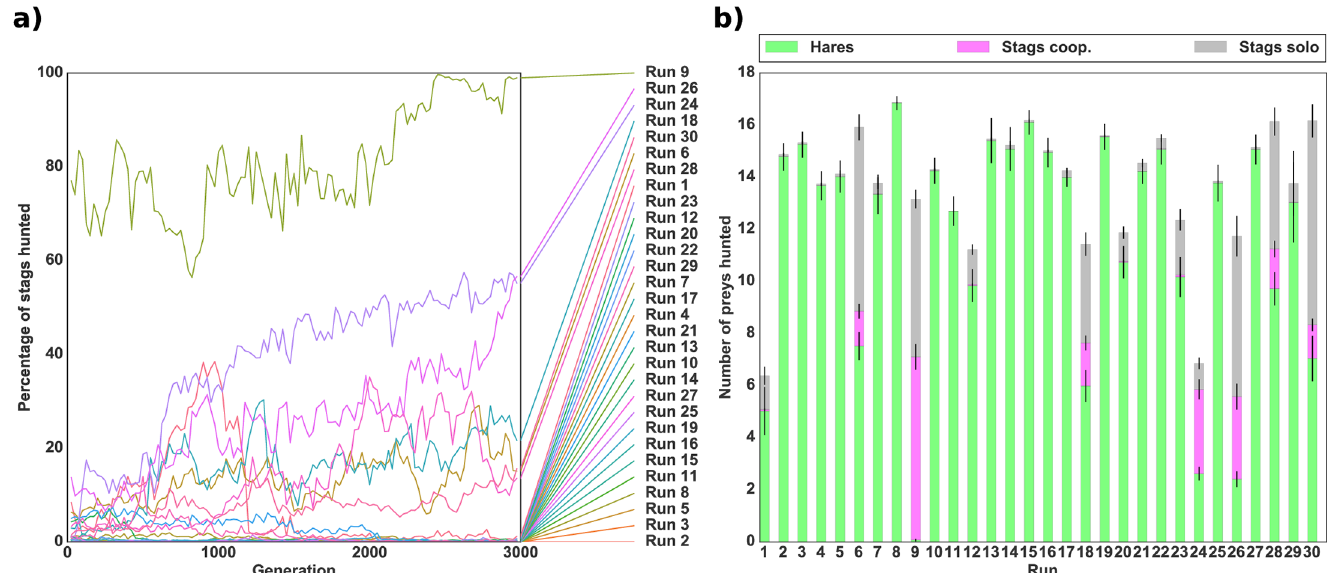
Fig 5. Evolution of cooperation with no initial hunting strategy. (a) Evolution of the mean percentage of stags hunted successfully (i.e. cooperatively) with respect to the total number of prey hunted in a robotic simulation. (b) Mean number of prey hunted during the last generation of evolution for each independent run. The bottom green bar represents the number of hares hunted, the middle pink bar the number of stags hunted successfully (cooperatively) and the top grey bar the number of failed hunts (stags hunted alone). The standard deviation for each quantity is shown by black lines. Rewards were 50 for a hare, 0 for a stag hunted alone, and 500 for a stag hunted cooperatively, as presented in Table 1. The number of prey (18) was kept constant throughout the simulation by replacing killed prey by a prey of the same type.